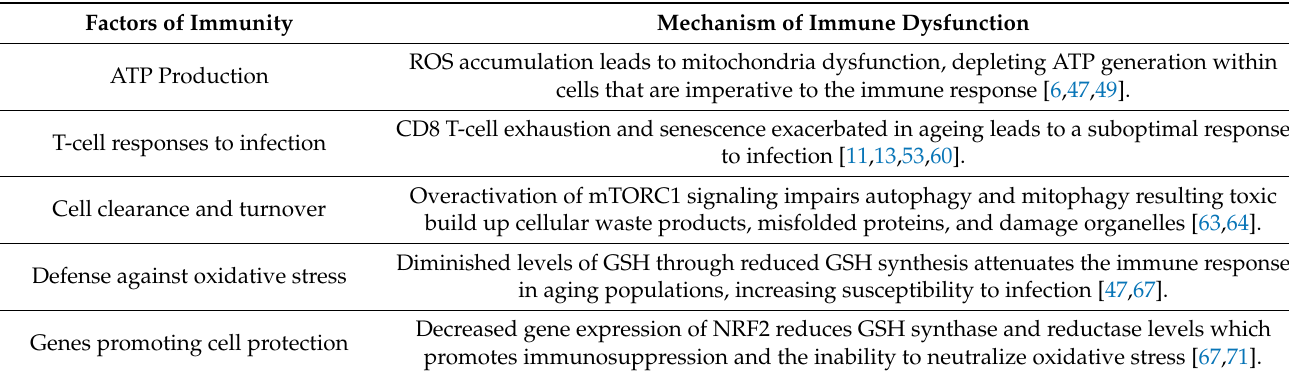
Table 2. Summary of ageing factors that increase susceptibility to M. tb